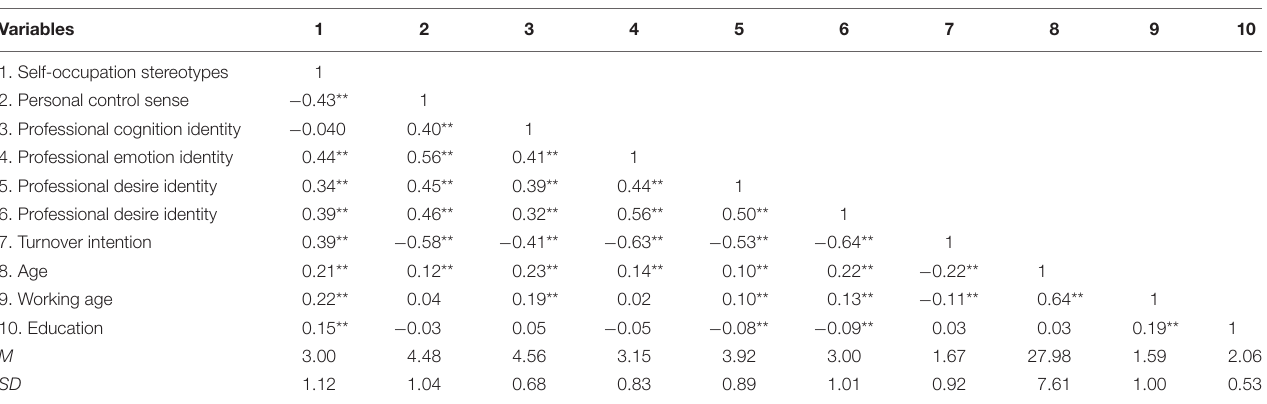
TABLE 1 | Means, standard deviations, and correlations between